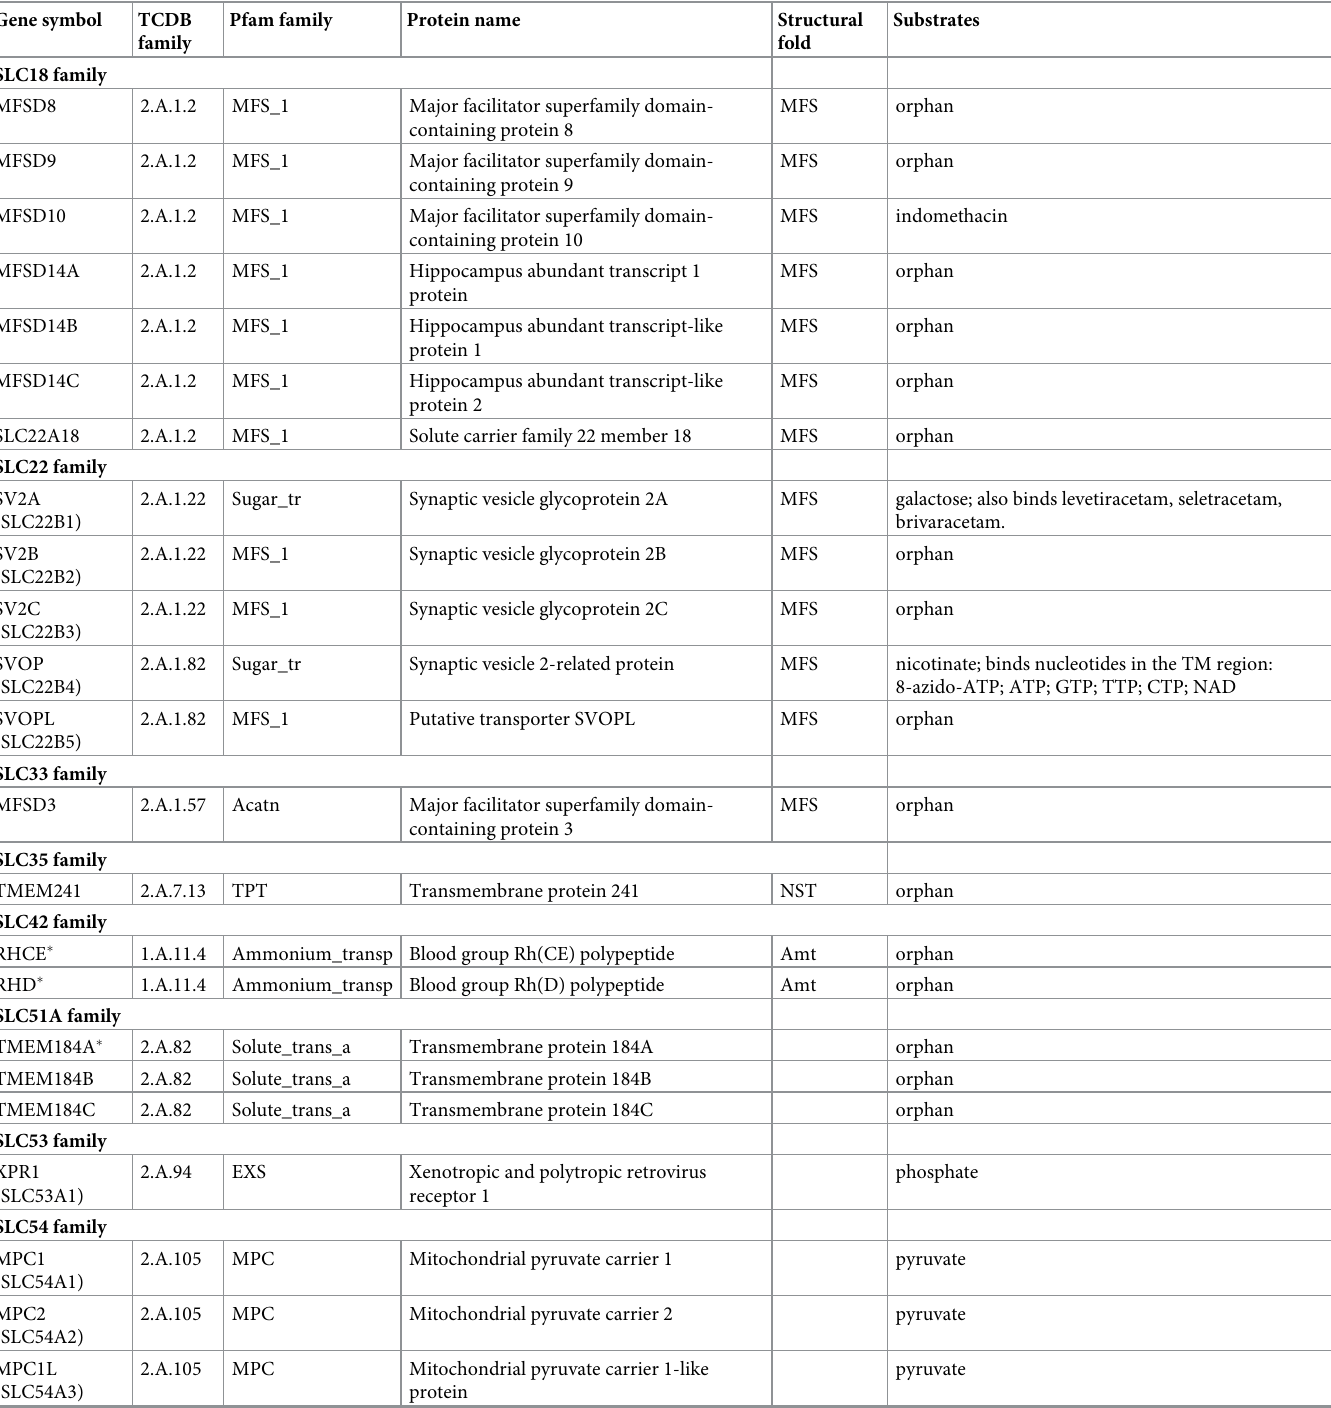
Table 3. Novel SLC-like proteins. The table shows SLC-like human proteins from our search that are not in the classic group of SLCs (SLC1-52 families). The most simi- lar (highest-scoring) TCDB family/subfamily and Pfam family are shown, as well as the most similar (highest-scoring) protein with structural information based on the pdb70 dataset (see Methods). Substrate information, where available, was retrieved from available literature. Based on our search, SLC families SLC53-66 have recently been incorporated into the nomenclature in collaboration with the HUGO/HGNC. Proteins marked with a single asterisk are included due to sequence similarity but may have functions other than transporter. Proteins marked with double asterisks might have a channel-like transport mechanism. For additional details, see S4